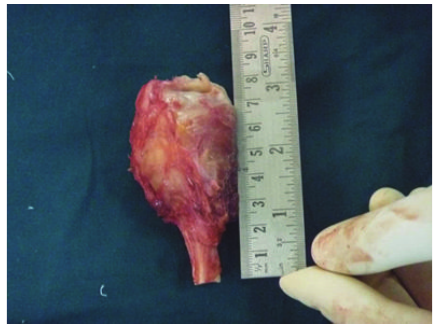
Figure 11: Free palmaris graft for tenodesis of DRUJ.